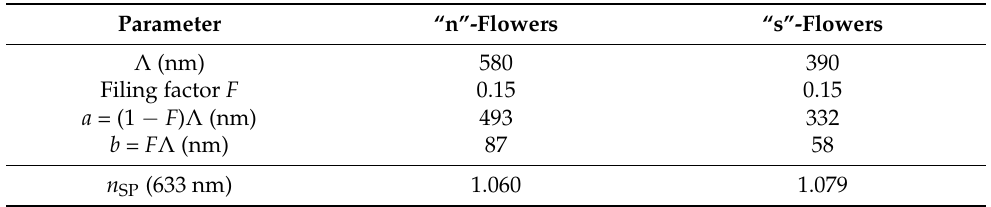
Table A1. Model grid parameters for the two types of silver flowers. The last row represents the surface-plasmon effective refraction index n SP , calculated at the wavelength λ 0 = 663 nm of the incident laser